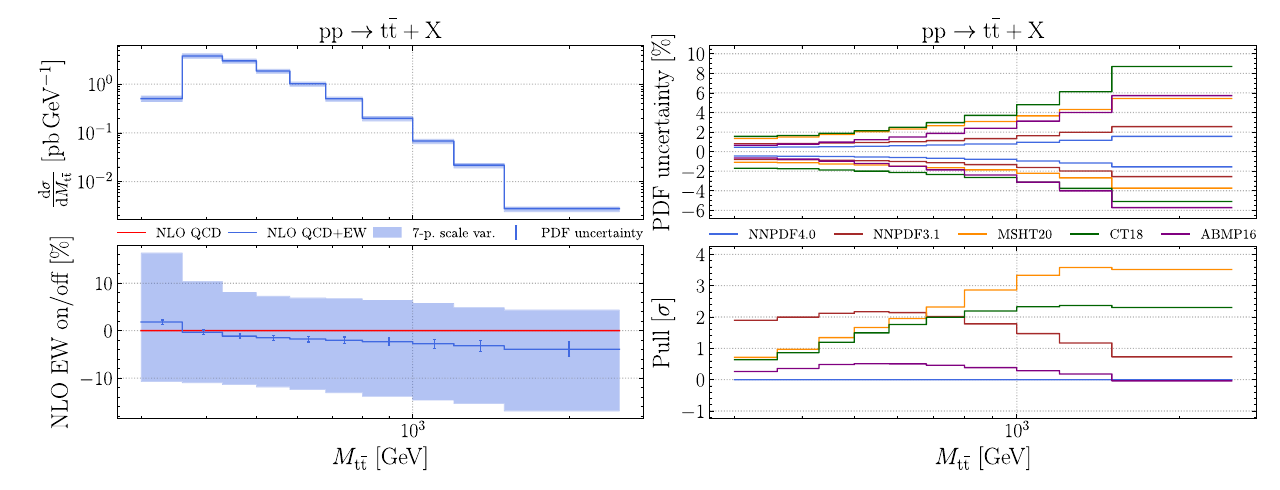
Fig. 69 Same as Fig. 63 for pp → t ¯ t + X